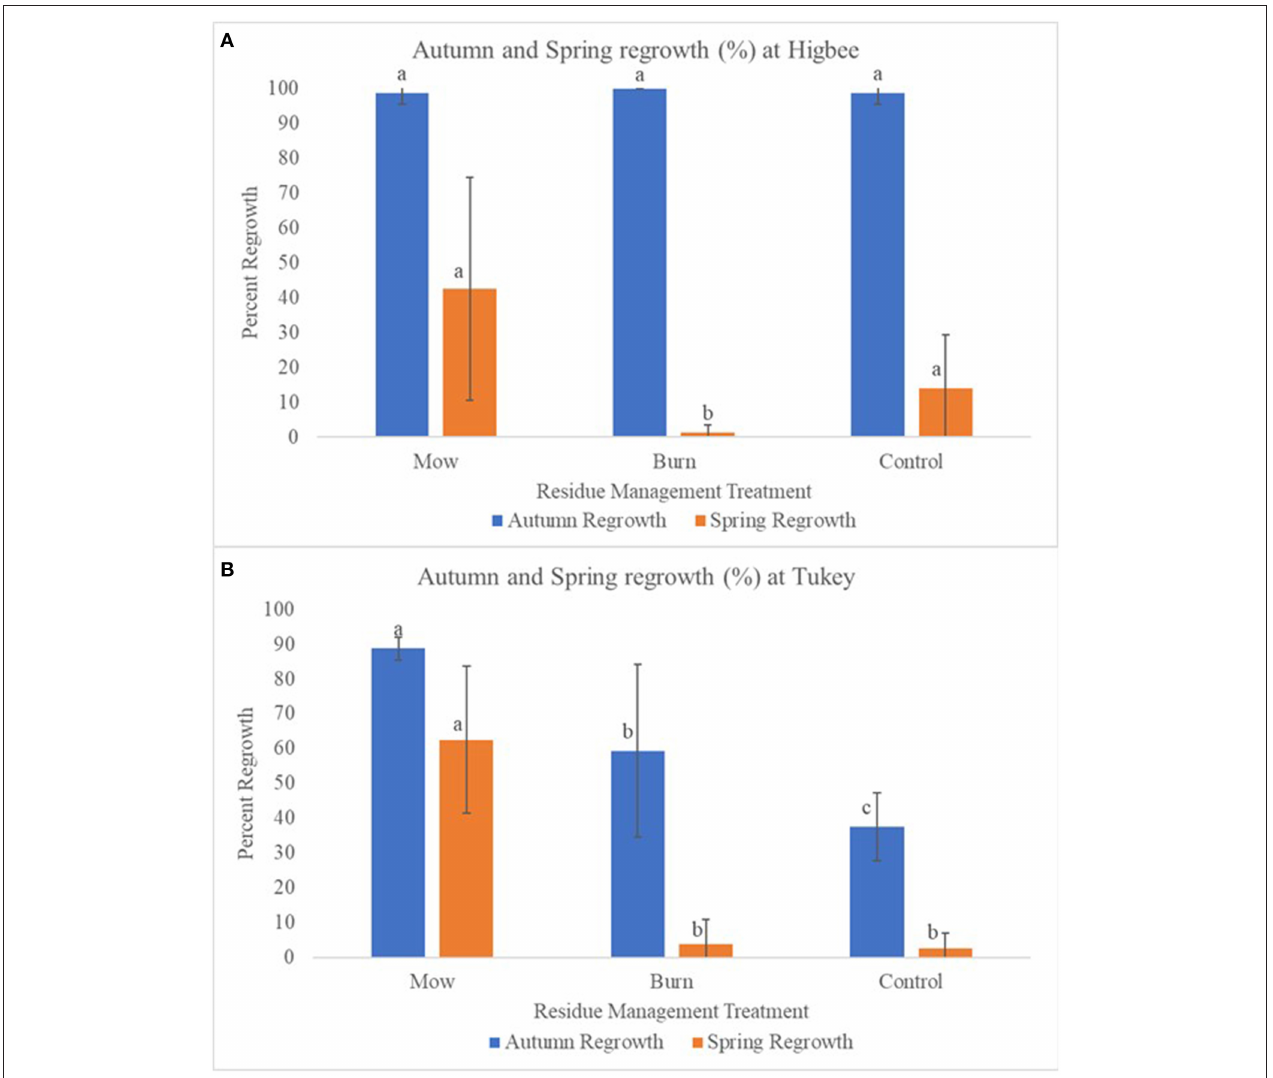
FIGURE 1 | Mean autumn 2016 and spring 2017 post-sexual cycle regrowth (%) across both SPS 9 and SPS 22 genotypes, following the first harvest comparing different residue management treatments (A) at Higbee and (B) at Tukey. Error bars represent standard deviation of the treatments. Means (bars) below the same letters “a,” “b,” or “c” across treatments and within season each season (autumn regrowth = blue bars; spring regrowth = orange bars) are not significantly different at α <